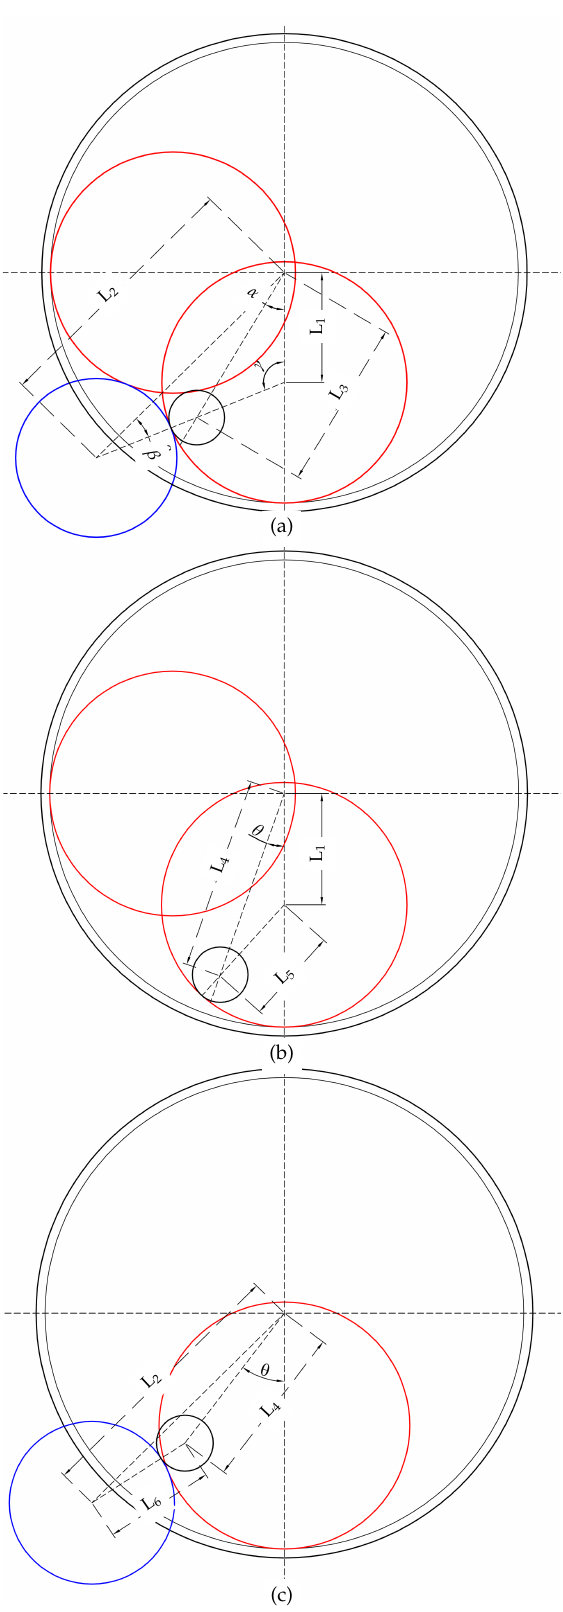
Figure 4. Determination of cylinder volumes. ( a ) Critical rotational angle; ( b ) contact point of roller with concave circle; ( c ) contact point of roller with convex circle.